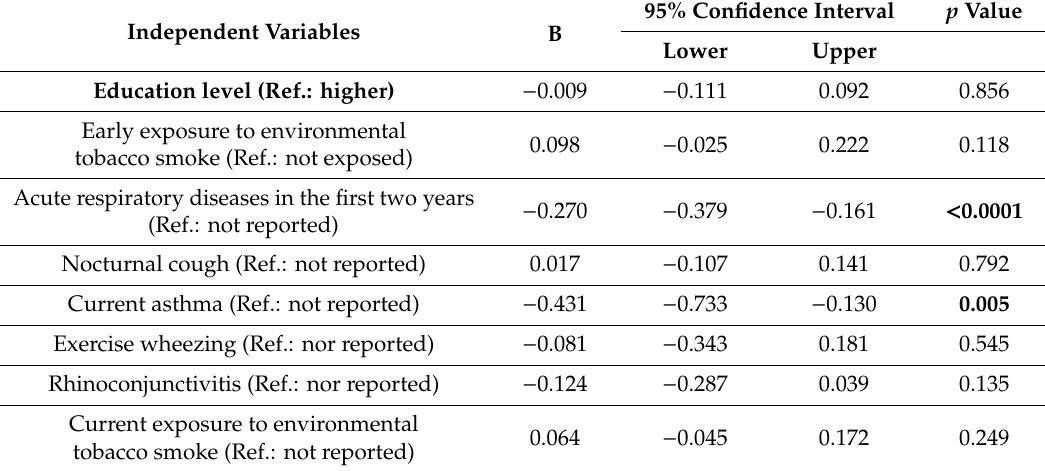
Table 7. Multiple linear regression model for FEF 25–75% (as z-score) in the overall study population ( n = 1714). Four combinations of exposure to maternal smoke during pregnancy and sex were separately evaluated. Significant p -Values are in